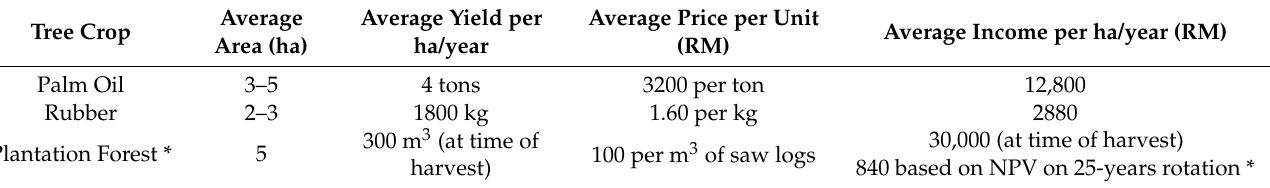
Table 7. Comparative Economic Benefits of Forest Plantation.